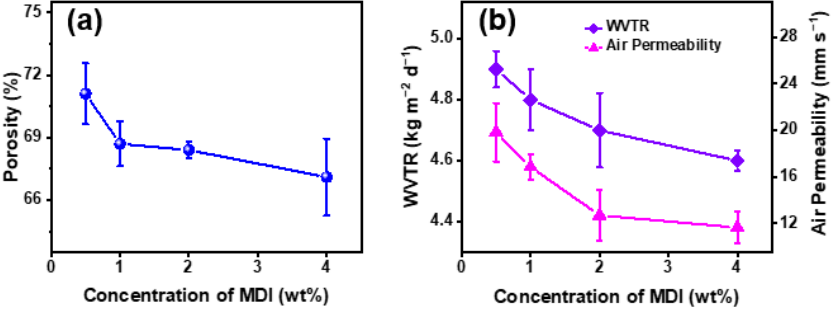
Figure 9. Moisture and air permeability of PAN@AMP-1/MDI nanofibrous membranes modified by in situ cross-linking of MDI with different concentrations: ( a ) porosity, ( b ) WVTR and air permeability.